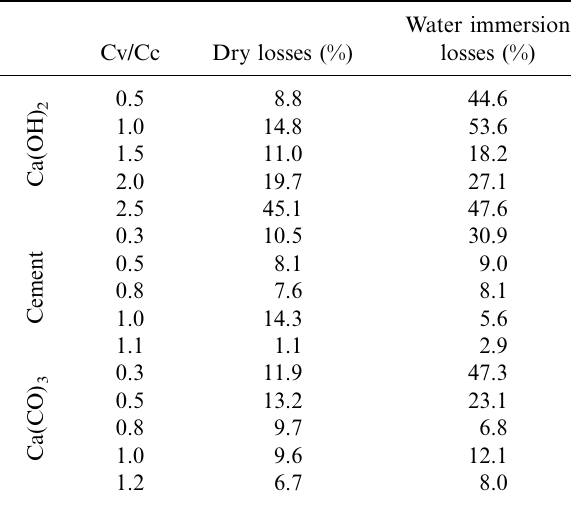
Table 3. Losses produced in adhesiveness test when dry